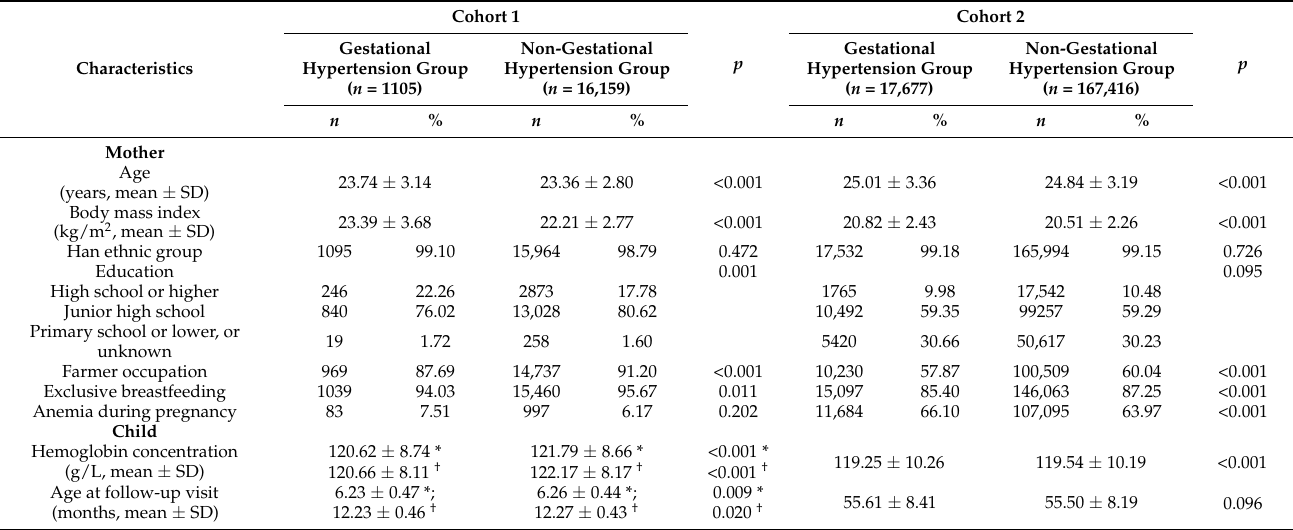
Table 1. Maternal and child characteristics according to gestational hypertension